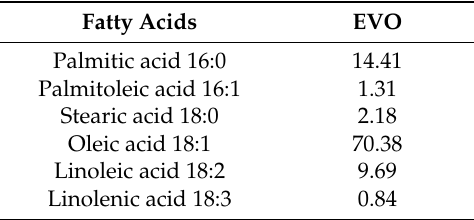
Table 1. Composition % m/m of fatty acids in extra-virgin olive oil (EVO). Fatty Acids EVO Palmitic acid 16:0 14.41 Palmitoleic acid 16:1 1.31 Stearic acid 18:0 2.18 Oleic acid 18:1 70.38 Linoleic acid 18:2 9.69 Linolenic acid 18:3 0.84